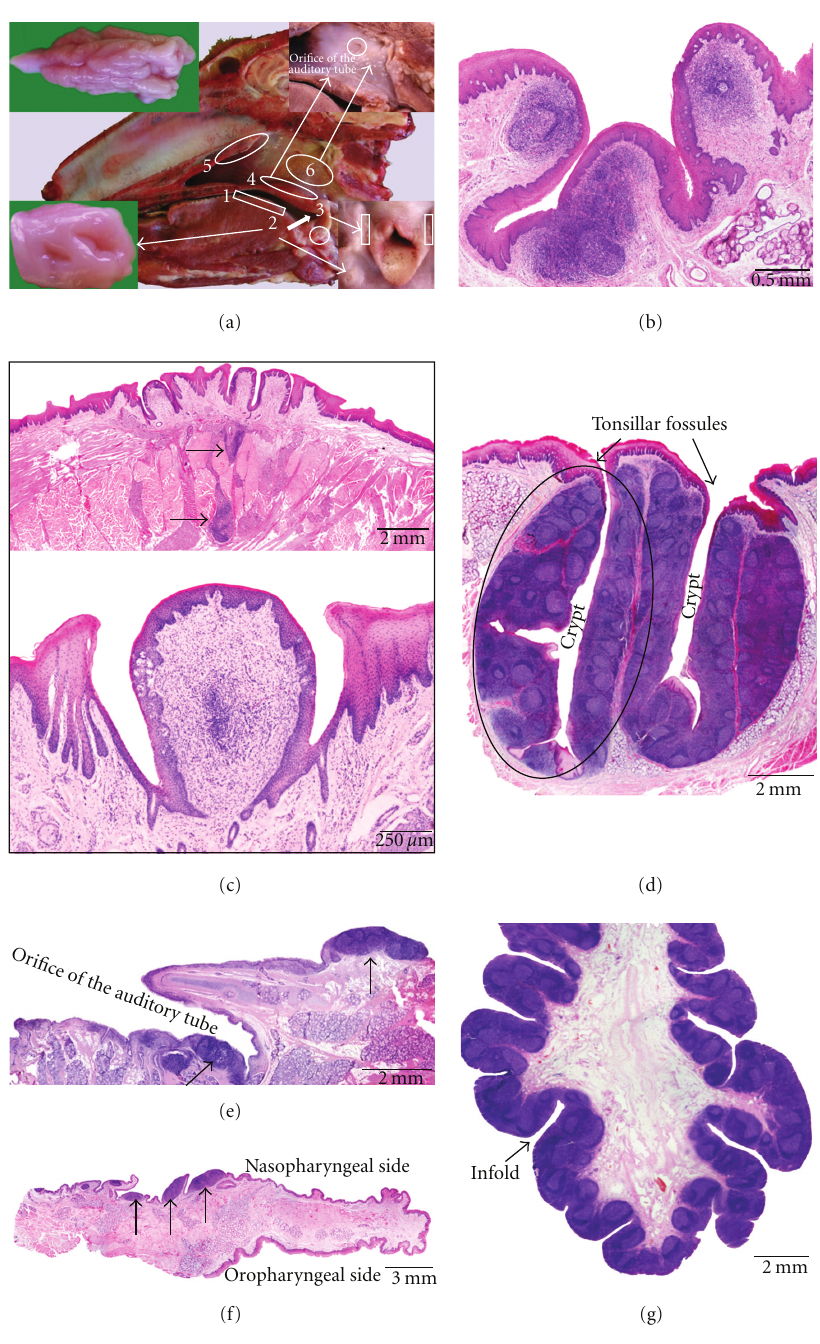
Figure 1: Anatomical localization and histological characteristics of the ovine tonsils. (a) Median section through an ovine head showing the location of the lingual tonsil (1), the palatine tonsil (2) of which a larger magnification is shown in the lower left insert, the paraepiglottic tonsil (3) that is located at the lateral basis of the epiglottis (lower right insert), the tonsil of the soft palate (4) consisting of scattered lymphoid nodules at the nasopharyngeal side of the soft palate (higher magnification after 2% acetic acid fixation for 4 h shown in the upper right insert), the pharyngeal tonsil (5) of which a larger magnification is presented in the upper left insert, and the tubal tonsil (6) consisting of scattered lymphoid nodules located caudoventral to the opening of the auditory tube (higher magnification after 2% acetic acid fixation for 4h also shown in the upper right insert). (b) Histological section through the paraepiglottic tonsil. (c) Histological images of the lingual tonsil. The upper view shows aggregations of lymphoid cells (arrows) in between the lingual muscles and salivary glands. The lower image demonstrates the presence of an aggregation of lymphoid cells in the connective tissue core of a vallate papilla. (d–g) Histological sections through the palatine (d) and tubal (e) tonsils, the tonsil of the soft palate (f), and the pharyngeal tonsil (g), respectively. A tonsillar follicle is encircled in (d); the lymphoid tissue in (e) and (f) is indicated by the